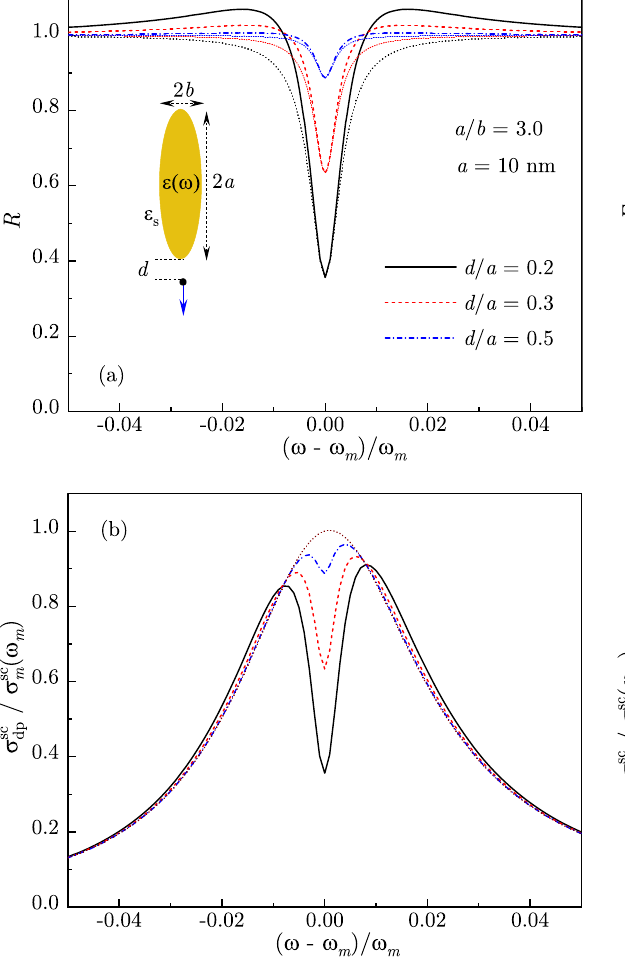
Figure 2: (a) The ExIT function R ( 𝜔 ), given by Eq. (35), and its asymptotic expression (dotted lines), given by Eq. (37), are shown for a QE near the tip of Au nanorod with aspect ratio a ∕ b = 3 . 0 and length 2 a = 20 nm at distances d ∕ a = 0 . 5, 0.3, and 0.2. (b) Normalized scattering cross-section in the dressed plasmon approximation is shown for the same system parameters. The dotted line is the plasmon band. All curves are calculated for 𝜔 = 𝜔 . Inset: schematics of a QE situated at a distance d from the e m tip of Au nanorod in water for QE dipole moment oriented along the nanorod axis.